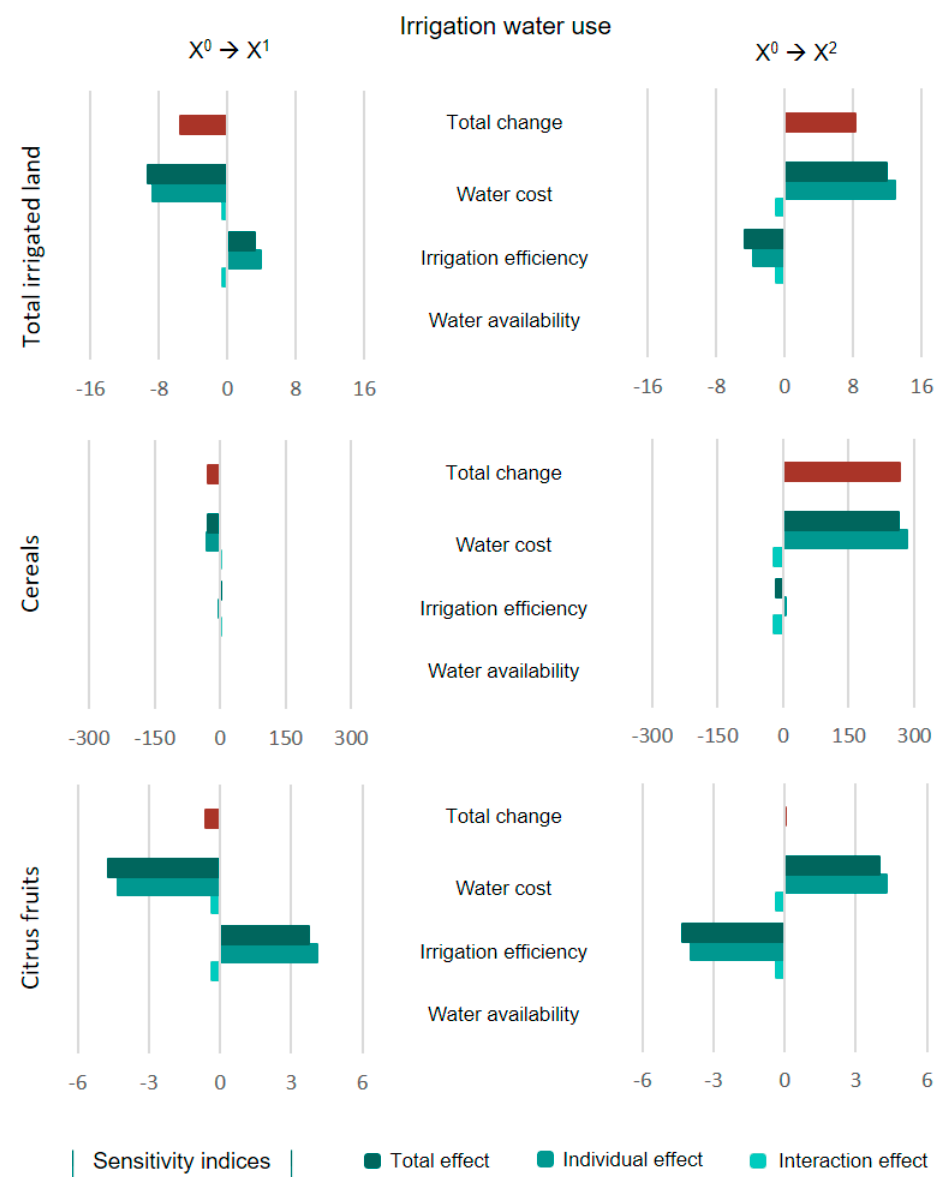
Figure 3. Sensitivity of irrigation water use (total, cereals and citrus fruits) to scenario drivers when shifting from the reference to the worst-case scenario ( left ) and to the best-case scenario ( right ). The total change in irrigation water use is decomposed into changes due to total, individual and interaction effects of each driver. The results are presented as % change from the reference scenario.